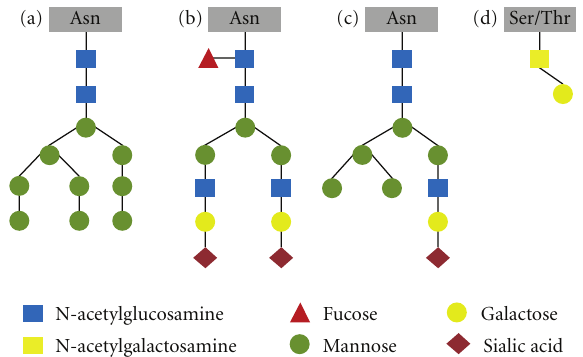
Figure 1: Oligosaccharide structure of the most common N-linked (a–c) and O-linked (d) glycans, including (a) high-mannose, (b) complex, and (c) hybrid glycans, and (d) the TF